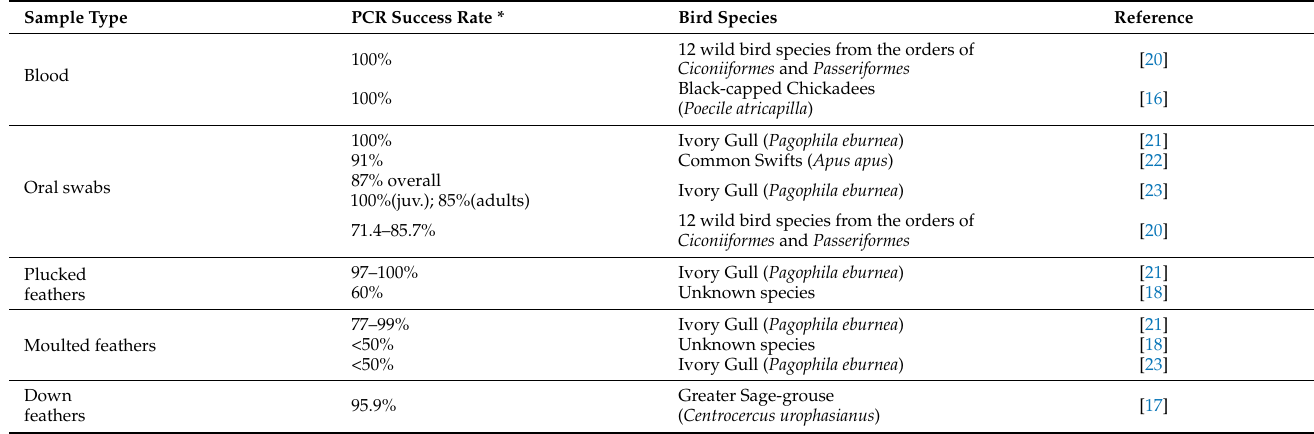
Table 1. PCR success rate for molecular sexing in birds using different biological